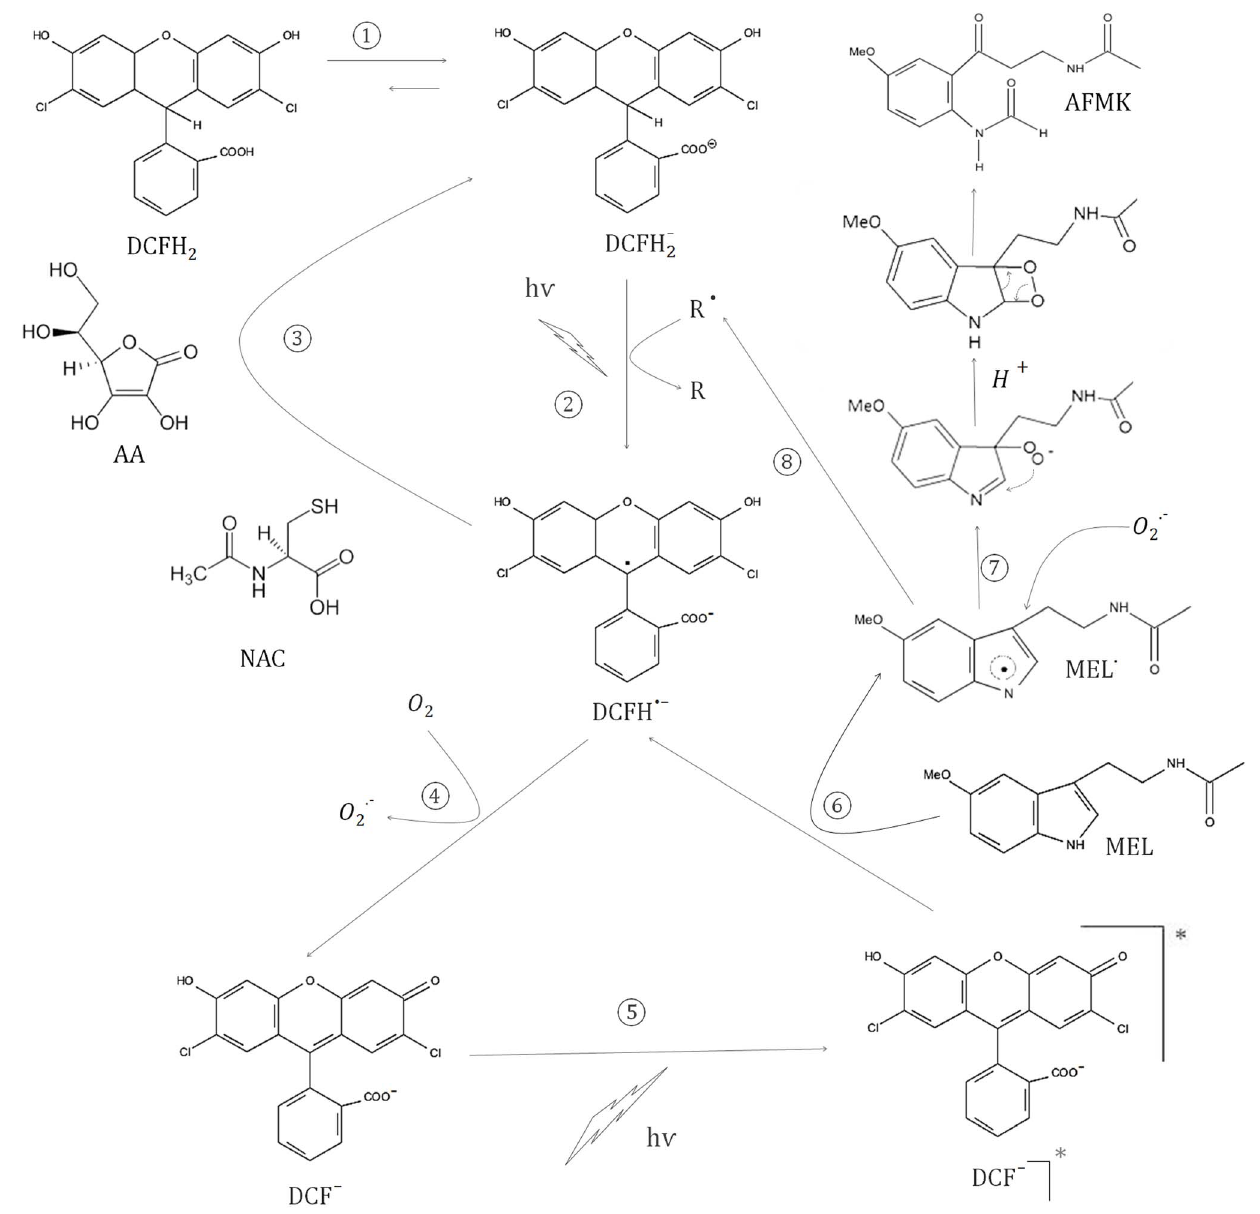
Figure 7. Diagram of proposal hypothesis about the mechanism of DCFH 2 , MEL and light reactions.